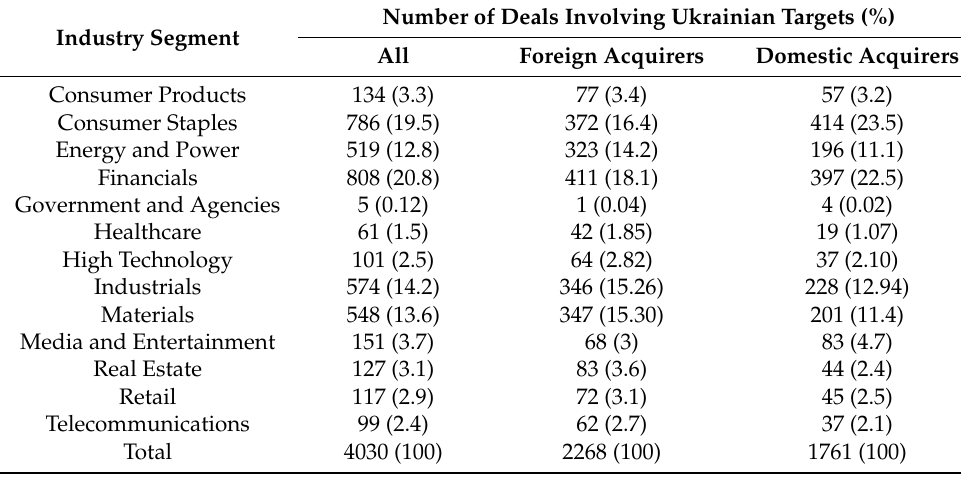
Table 2. Ukrainian acquisitions by industry, in total, and per acquirer type.